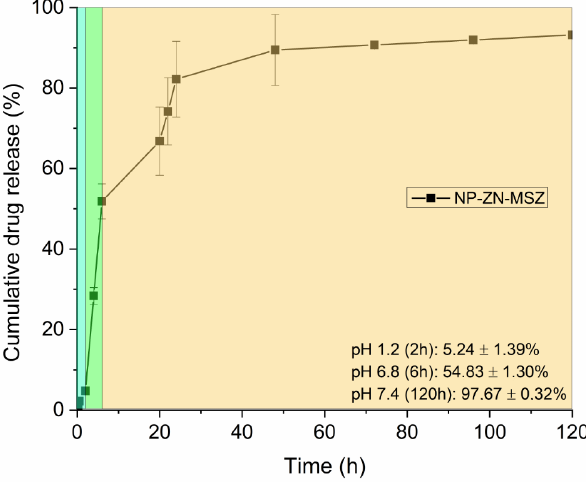
Figure 8. MSZ release profile of NP-ZN at pH 1.2, pH 6.8 and pH